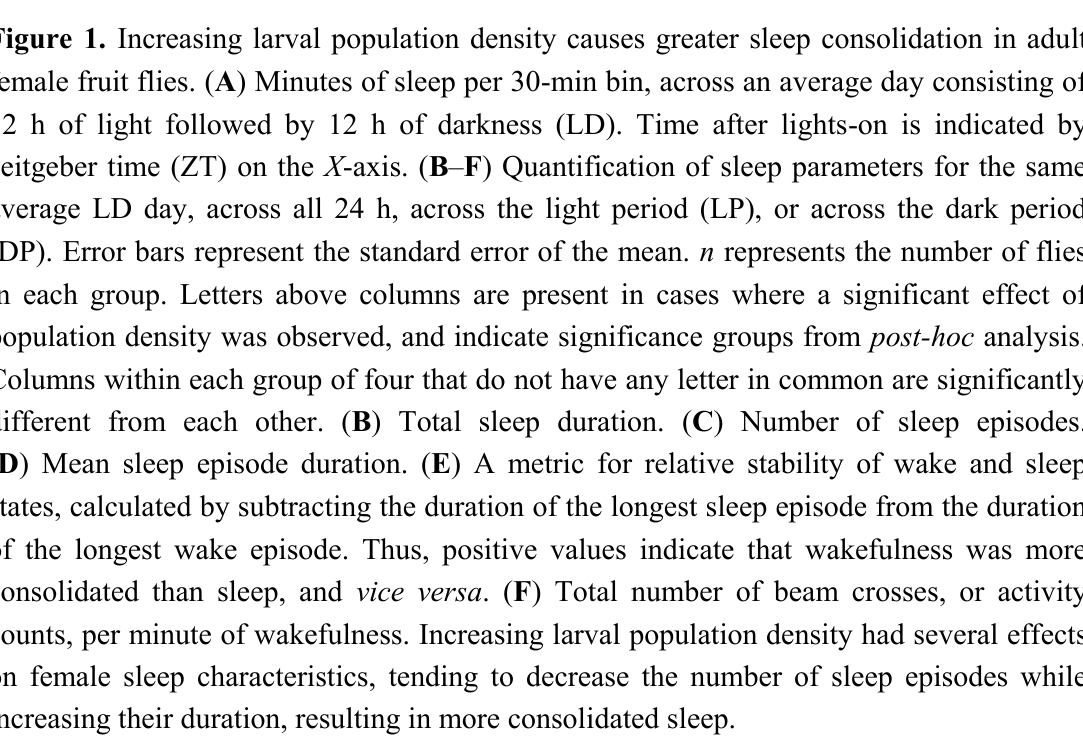
Figure 1. Increasing larval population density causes greater sleep consolidation in adult female fruit flies. ( A ) Minutes of sleep per 30-min bin, across an average day consisting